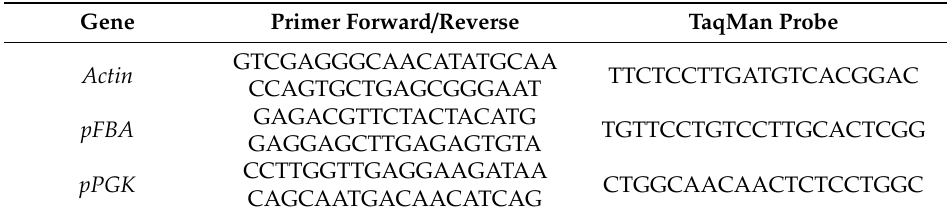
Table 1. Sequences of primers and TaqMan probes for the target and reference genes in Lolium multiflorum / Festuca arundinacea introgression forms: plastid fructose-1,6-bisphosphate aldolase (pFBA), plastid phosphoglycerate kinase (pPGK), and actin, used in RT-qPCR